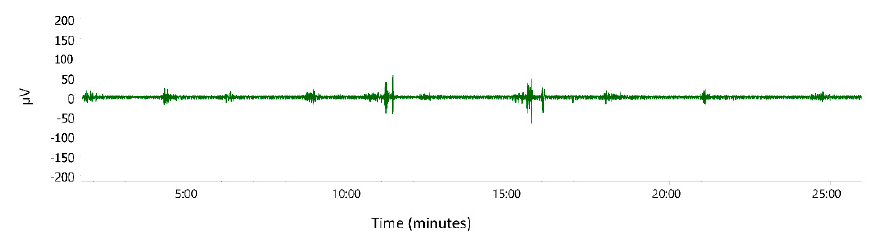
Figure 2. EHG recording with visible burst-like contractile elements (»pseudo-bursts«).